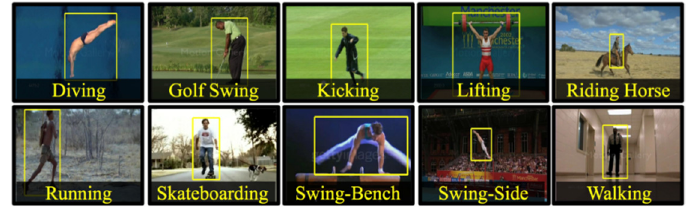
Figure 17. Exemplar frames from sports action dataset.